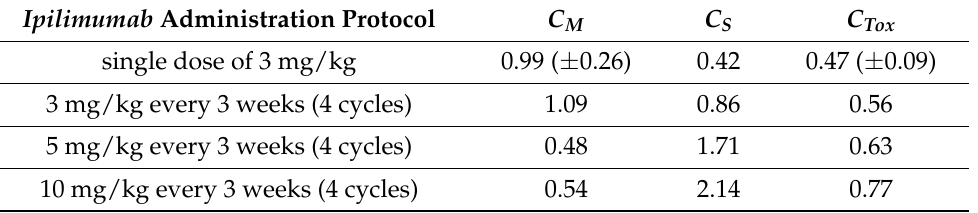
Table 2. Toxicity coefficients computed by considering the data reported in Table 1. C M and C S represent the coefficients of toxicity of moderate and severe adverse events employed to evaluate the toxicity coefficient ( C Tox ) for a given protocol by the Equation (3). The coefficient of the single ipilimumab dose is represented by its average value standard deviation, since the corresponding ± reported data allow us to only estimate a possible range of